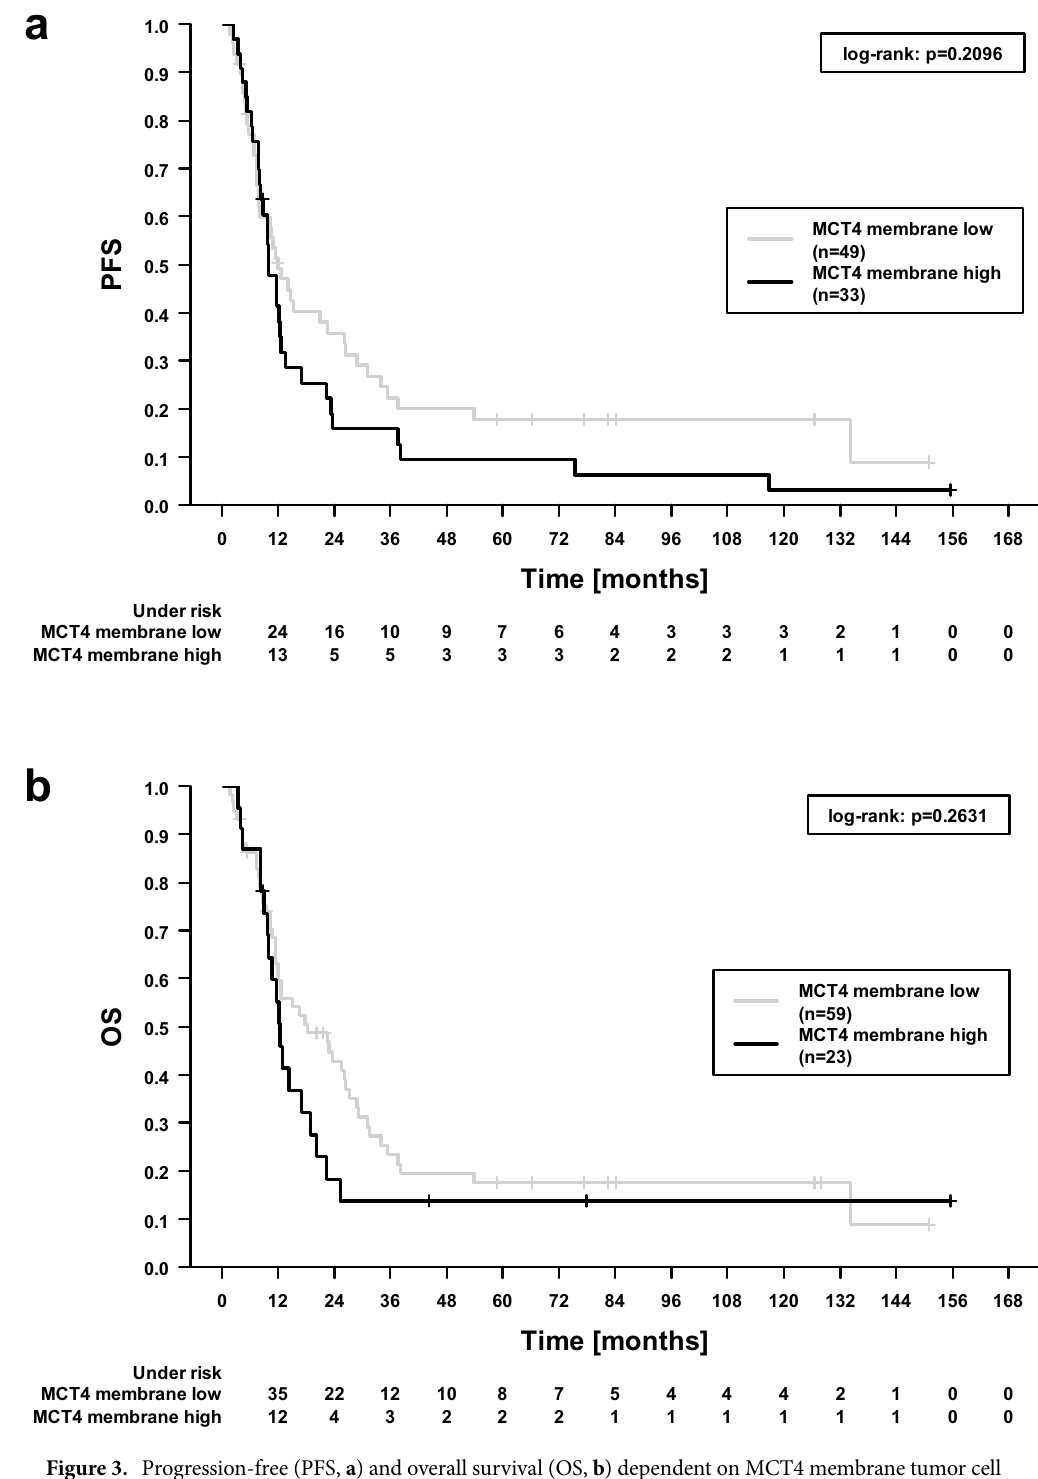
Figure 3. Progression-free (PFS, a ) and overall survival (OS, b ) dependent on MCT4 membrane tumor cell status; “high” denotes an immunohistochemical score ≥ 165 and ≥ 215 regarding PFS and OS, respectively. The denoted p values refer to log-rank